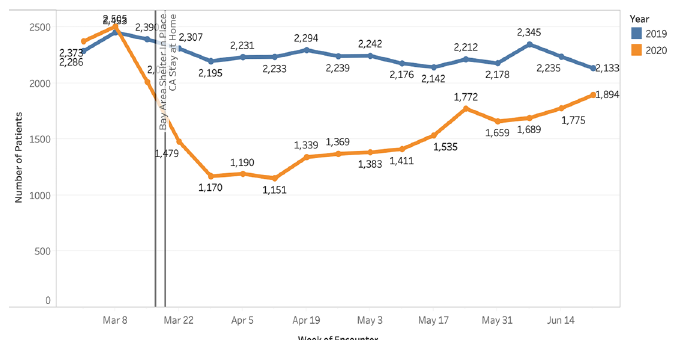
Figure 1. Overall weekly changes in emergency department